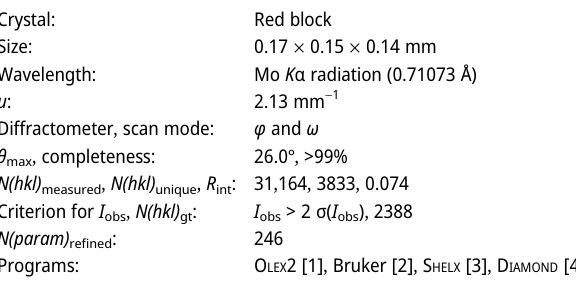
Table 1 contains crystallographic data and Table 2 contains the list of the atoms including atomic coordinates and displacement parameters.